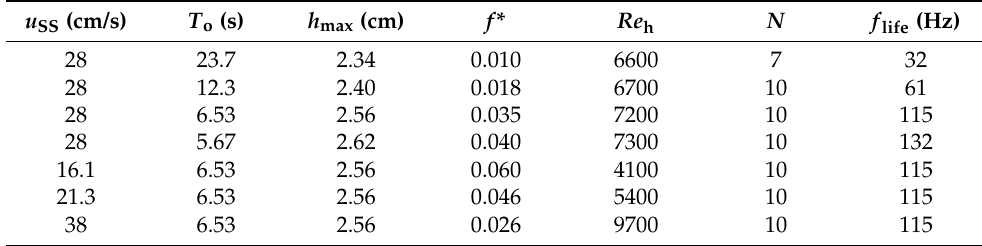
Table 1. Cases studied. Glottal jet velocity scale u SS is the flow speed in the glottis with the glottis held open at maximum opening h max . Glottis open time T o is the time glottis takes to open and close. f* is the reduced frequency of vocal fold vibration, Re h the Reynolds number, N the number of realizations collected for each case, and f life the equivalent life-scale frequency for each